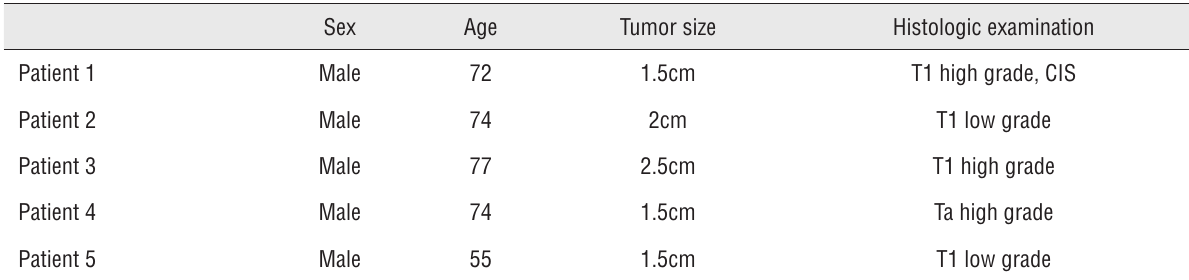
Table 1 - patient